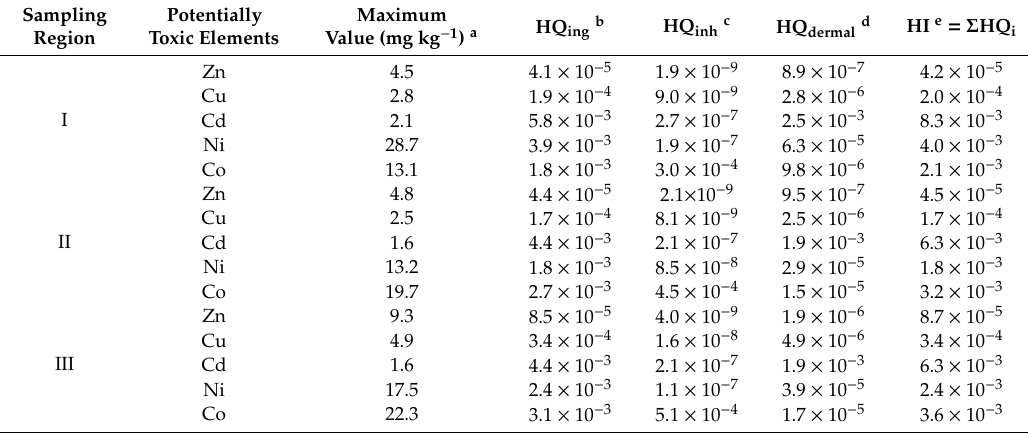
Table 1. Human health risk assessment of the potentially toxic elements in the surface soils of the Syr Darya River